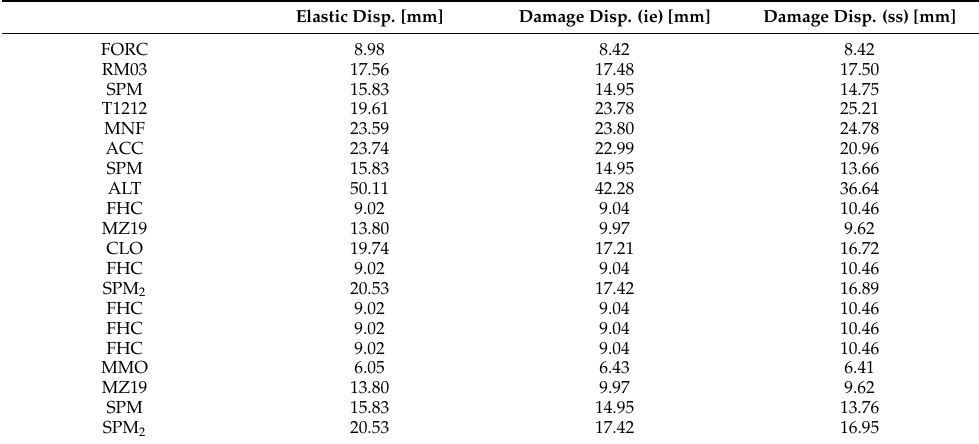
Table 5. Maximum elastic and damage displacement for individual event (ie) and seismic sequence (ss).